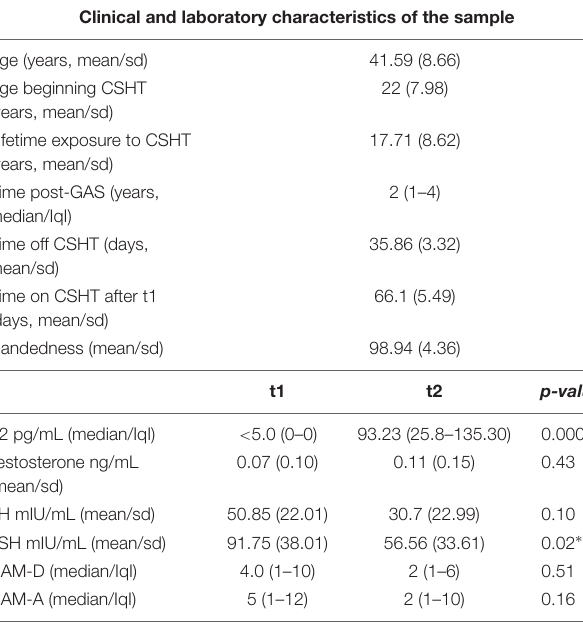
TABLE 1 | Clinical and laboratory characteristics of the sample.